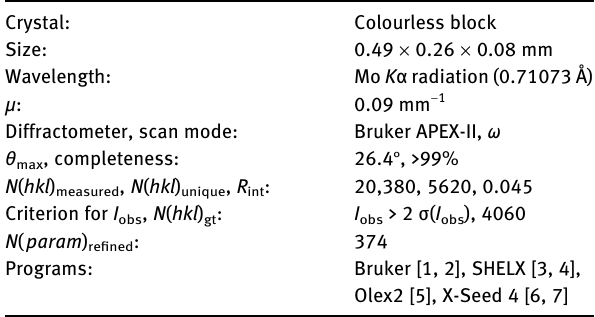
Table  : Data collection and